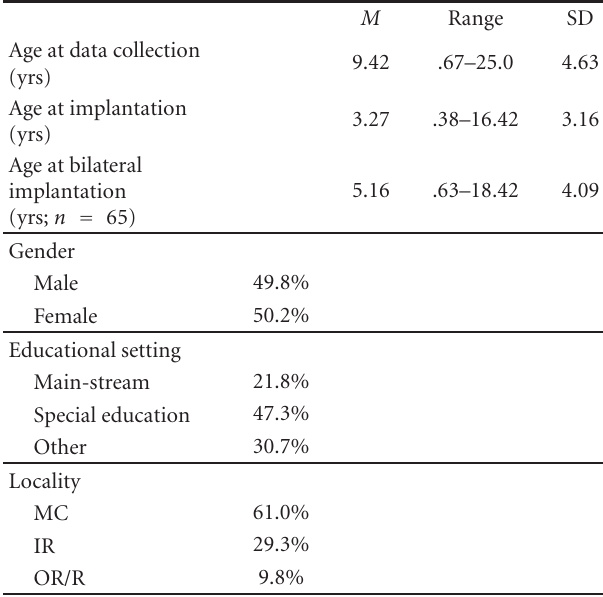
Table 1: Characteristics of children in the parent surveys ( N =